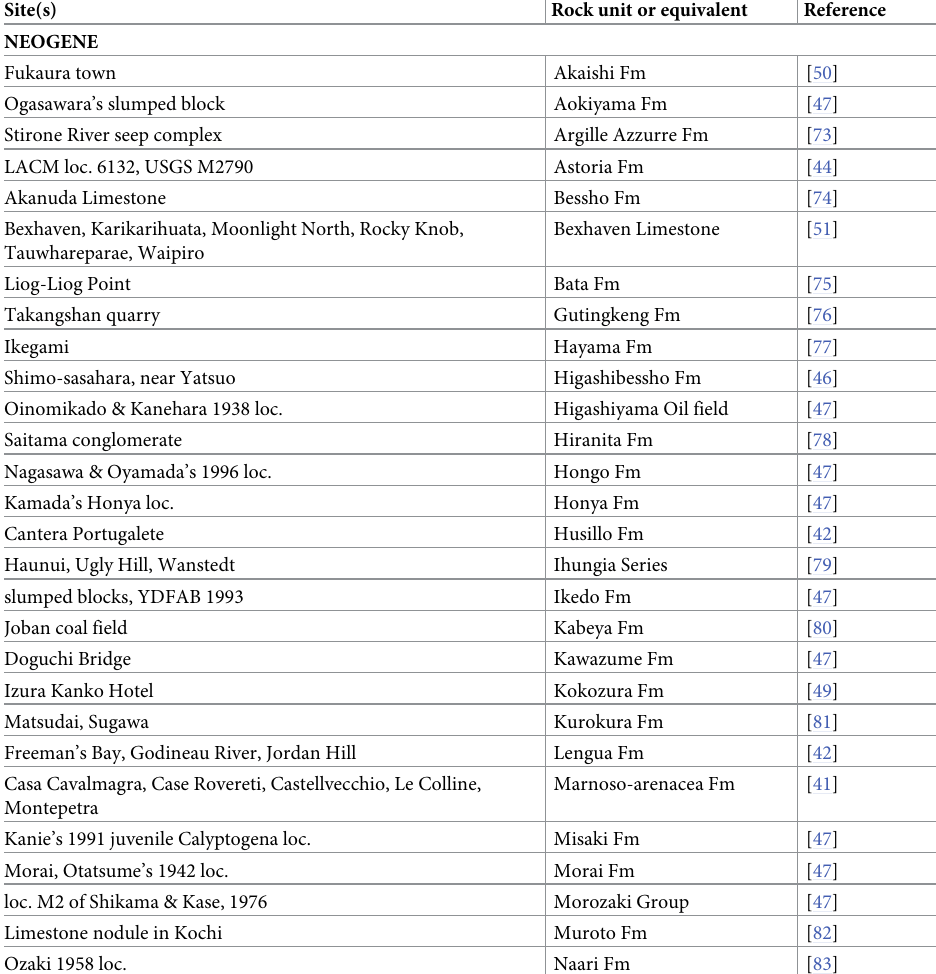
Table 2. Seep-bearing rock units or equivalents, sorted into the same geologic time bins as the genera in Table 1; Fm = Formation. Site(s) Rock unit or equivalent